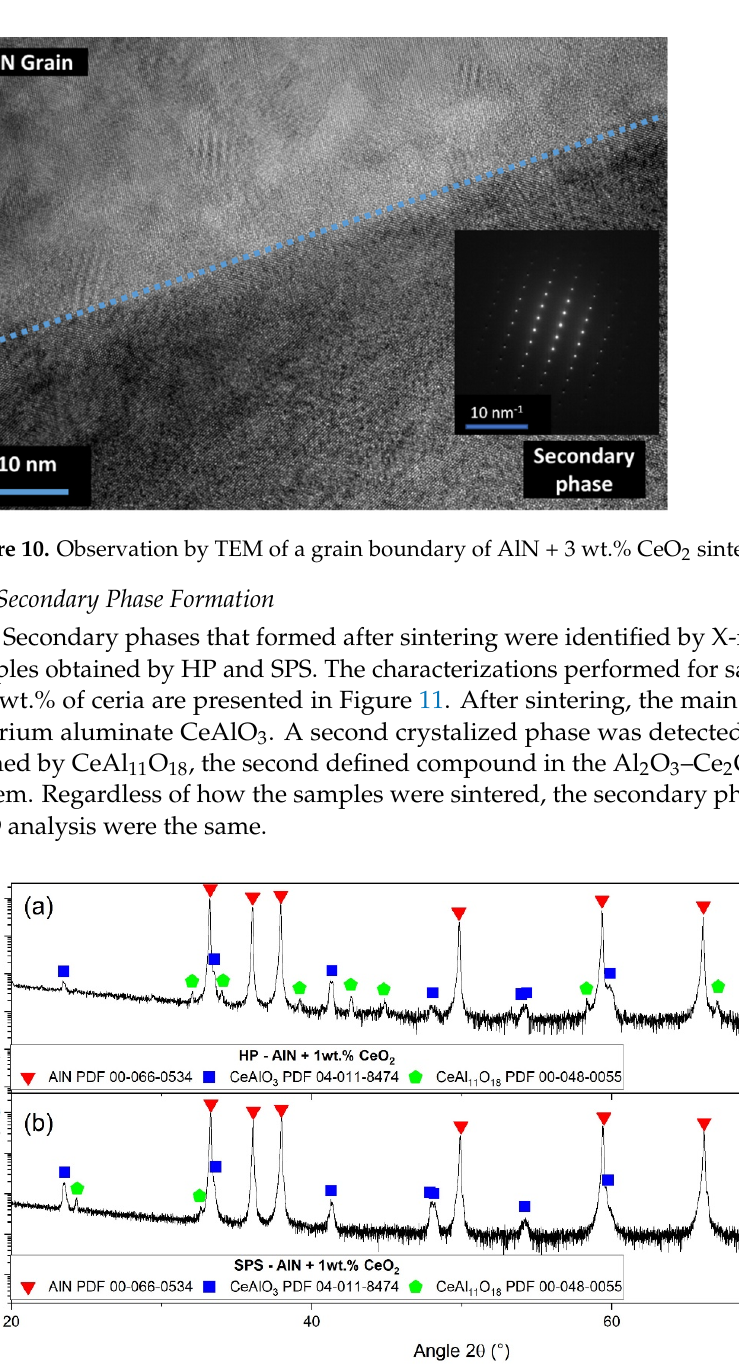
Figure 9. Microstructure of AlN + 3wt.% CeO 2 samples polished in situ by SEM-FIB. ( a ) sample sintered by HP, ( b ) sample sintered by SPS.